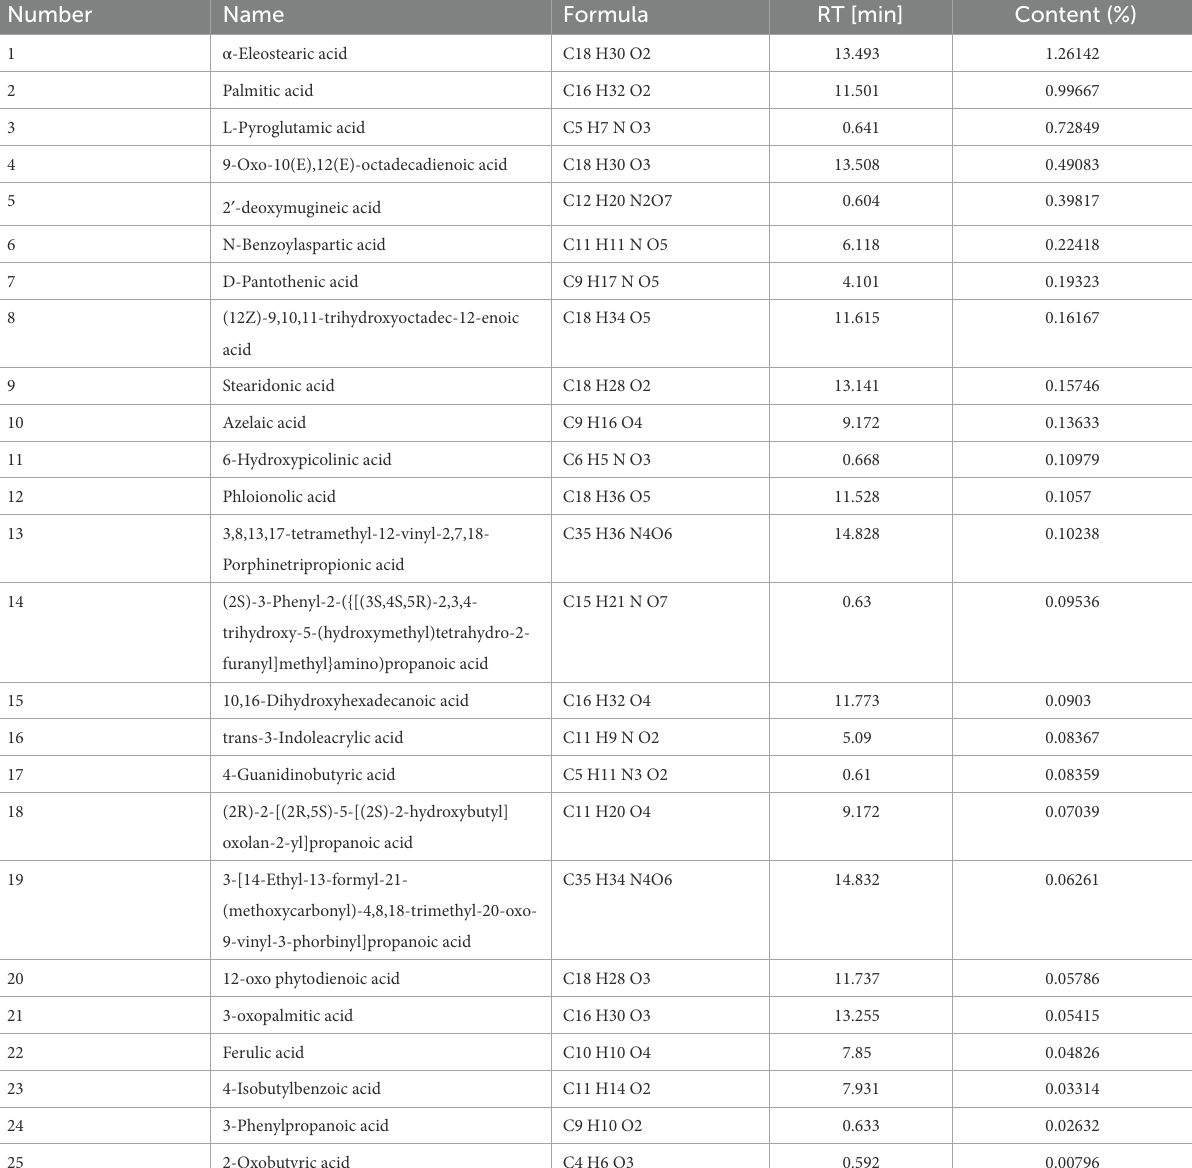
TABLE 1 Top 25 organic acids chemicals in